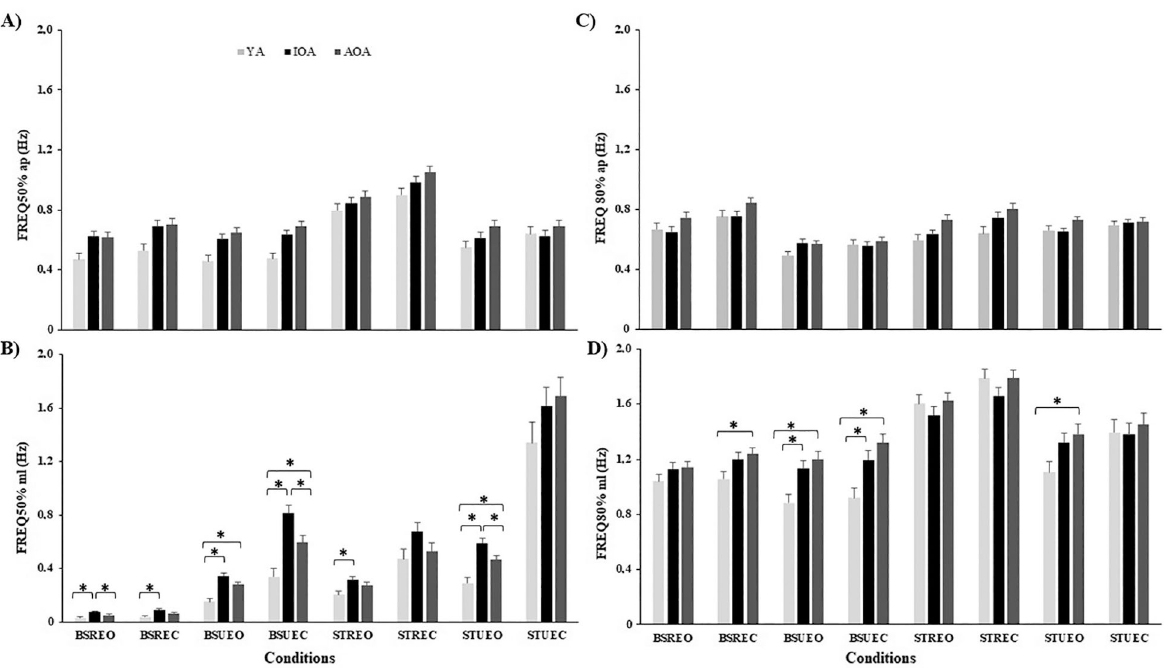
Figure 2 - Mean and standard deviation of the FREQ50_AP (A), FREQ50_ML (B), FREQ80_AP (C), and FREQ80_ML (D) variables for the YA, AOA, and IOA groups under